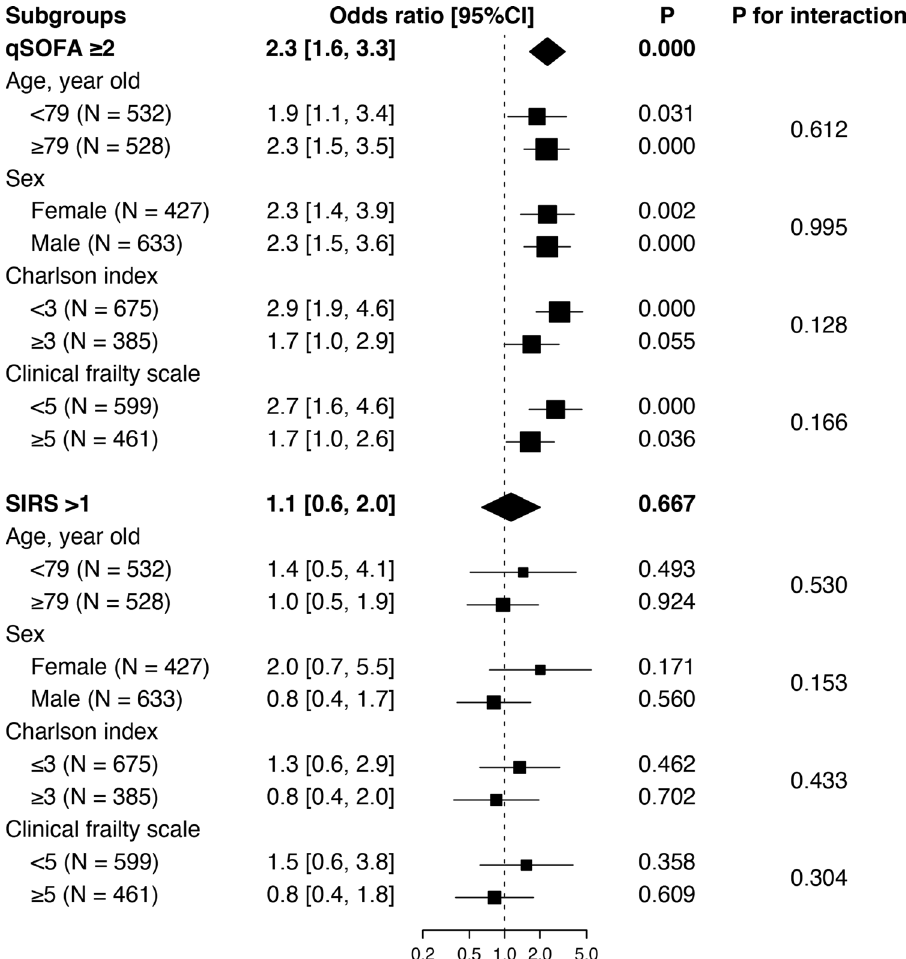
Figure 3. Explanatory subgroup analysis. Study participants were dichotomised according to age (median), sex (female or male), Charlson index (median), and clinical frailty scale score (median) and were subjected to subgroup analysis. The association between positivity of the tested scores (qSOFA ≥ 2 and SIRS criteria ≥ 2) and in-hospital mortality was indicated as an odds ratio with its 95% confidence interval (95% CI). qSOFA quick sequential (sepsis) organ failure assessment, SIRS systemic inflammatory response syndrome, 95% CI 95% confidence